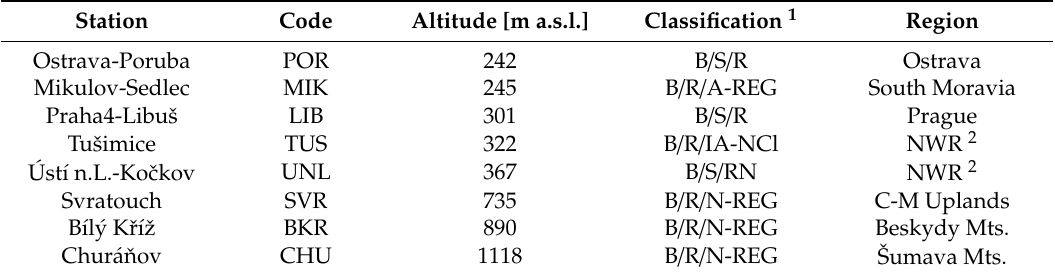
Table 1. Measuring sites (location in map in Figure 2), the long-term records of which are presented in Figures 8 – 11.